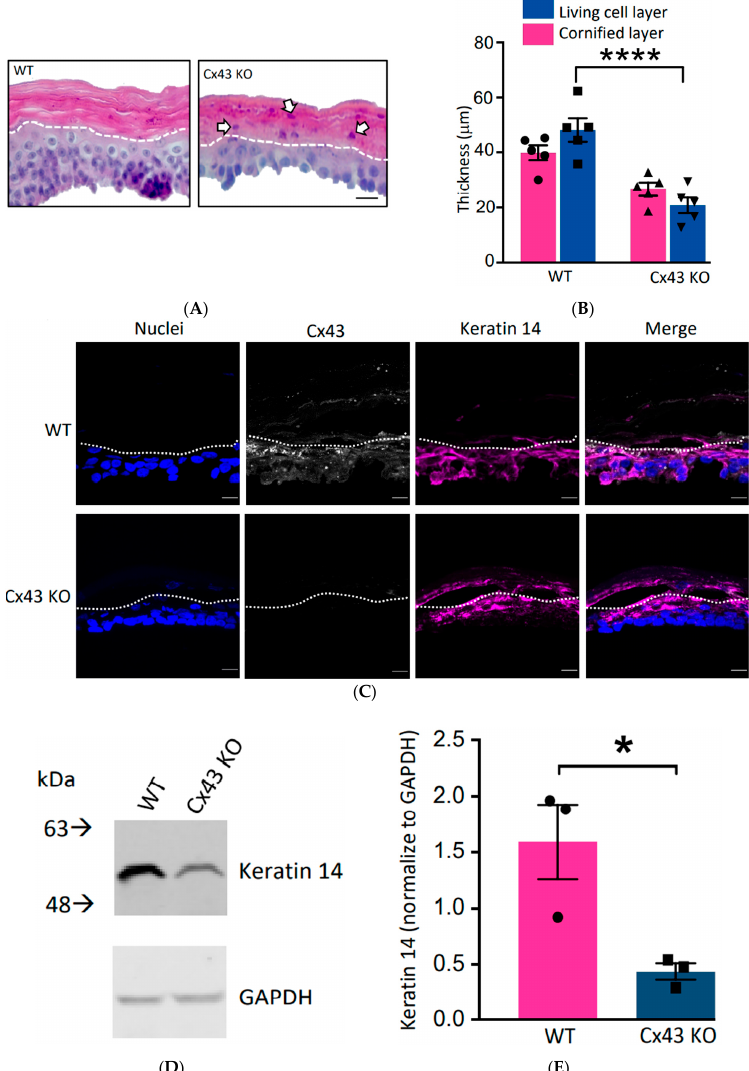
Figure 5. Ablation of Cx43 impairs REKs from fully differentiating in 3-dimensional cultures. ( A ) Wild-type (WT) and Cx43 knock out (Cx43 KO) REKs were grown at a liquid-air interface for three weeks and stained with hematoxylin and eosin. Note that the Cx43 KO epidermis cultures were thinner and many more nuclei were trapped within the cornified layers (arrows) above the dashed line. Bar = 20 μ m. ( B ) Quantification of the artificial epidermis thickness revealed that the living cell layer was remarkably thinner when Cx43 KO cells were used. **** p < 0.001. Solid circles represent scattered measures of the WT cornified layer while solid squares represent scattered measures of the WT living cell layer. Right-side up triangles represent scattered measures of the Cx43 KO cornified layer while upside-down triangles represent scattered measures of the Cx43 KO living cell layer. ( C ) Immunolabeling for Cx43 and keratin 14 revealed that there was a delay in the Cx43 KO cells in silencing keratin 14 expression and/or its degradation as this cytokeratin persisted in the cornified layer (above the dotted line). Nuclei were stained with Hoechst dye. Bar = 20 μ m. ( D , E ) Immunoblotting and quantification revealed that total keratin 14 levels were significantly reduced in Cx43 KO epidermis cultures when normalized to GAPDH. * p < 0.05, data plotted as ± SEM. Solid circles represent scattered measures of WT samples while solid squares represent scattered measures of Cx43 KO samples.